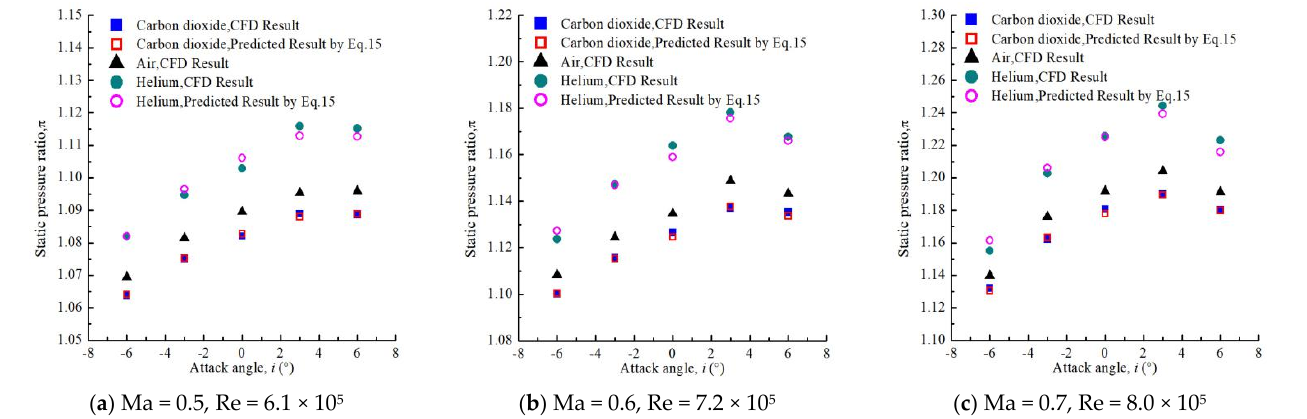
Figure 10. Static pressure ratio at different attack angles.